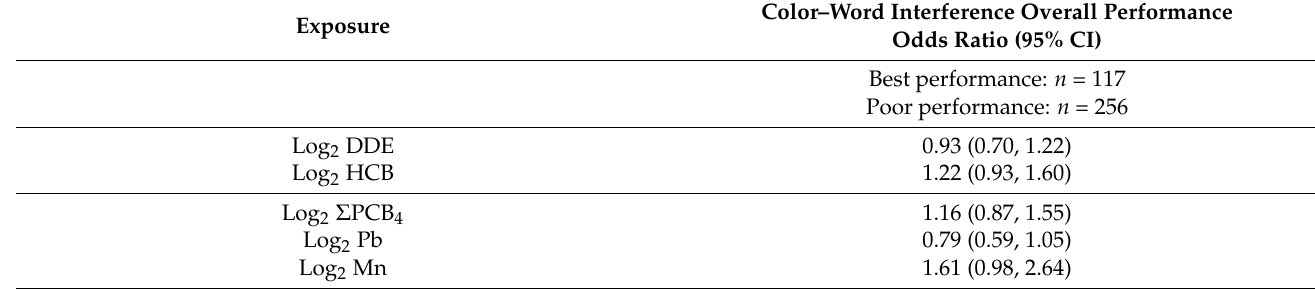
Table 6. Complete-case results of logistic regression analyses (odds ratio and 95% CI) 1 assessing the relation of prenatal exposure to a five-chemical mixture with odds of poor Delis–Kaplan Executive Function System (D-KEFS) Color–Word Interference: Inhibition overall performance among adolescents in the main analysis group 2